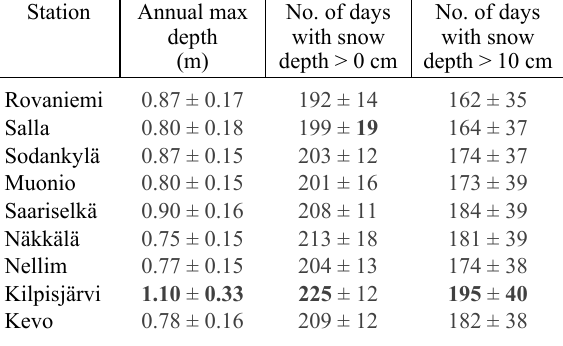
Table 2. Statistics of the snow conditions averaged over 30 years (1982–2011) in Finnish Lapland. Relatively large values